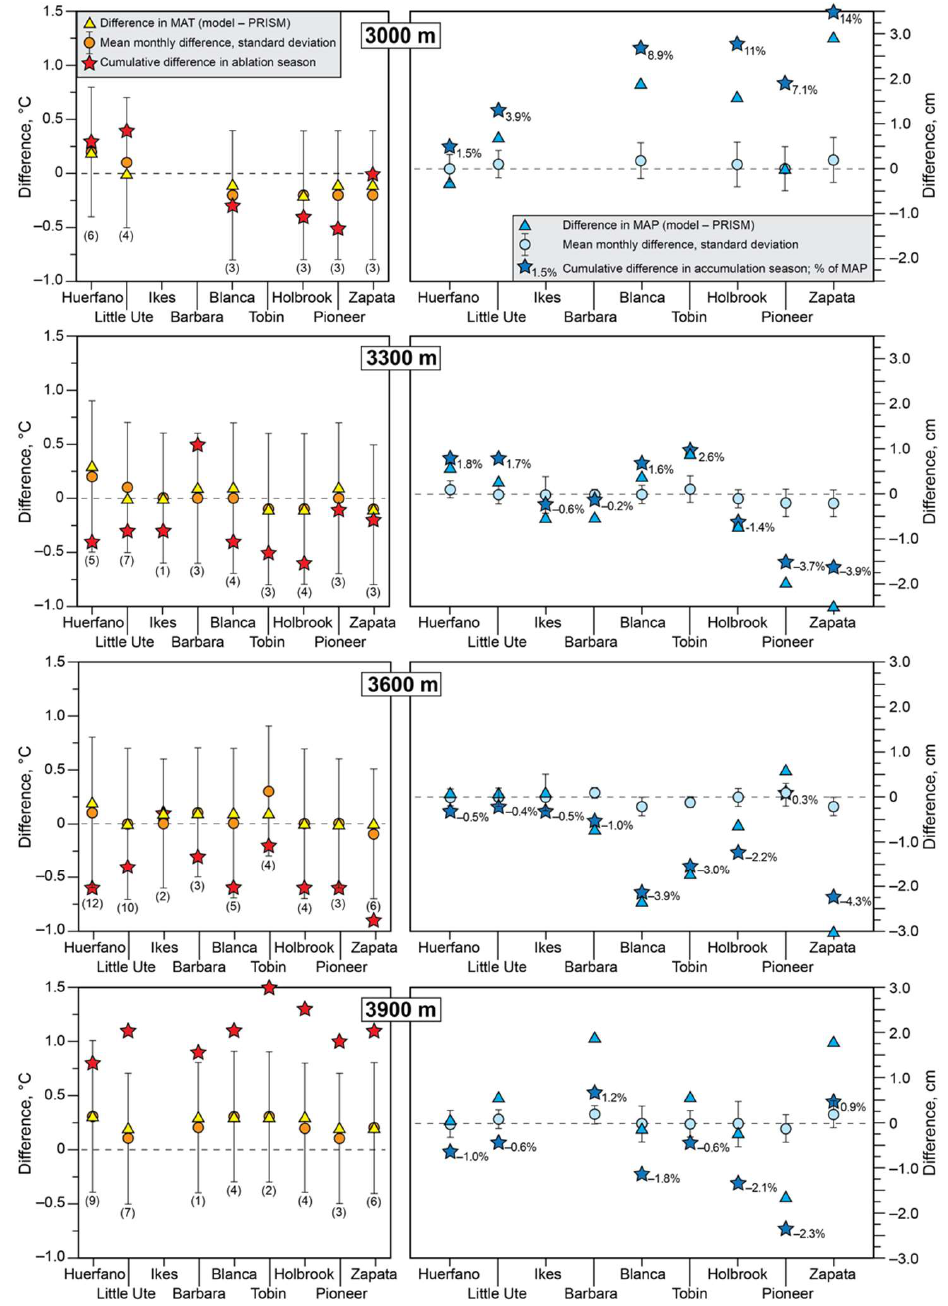
Figure 7. Comparison of modeled modern temperature and precipitation with PRISM values at select elevations in the study area. MAT and MAP are mean annual temperature and precipitation respectively. Positive values indicate simulated temperatures/precipitation are warmer/wetter than those obtained from PRISM climatology. Numbers in parentheses in temperature data refer to the number of PRISM values used to evaluate both simulated temperatures and precipitation. Elevation ranges shown account for ≥90% of glacier areas.